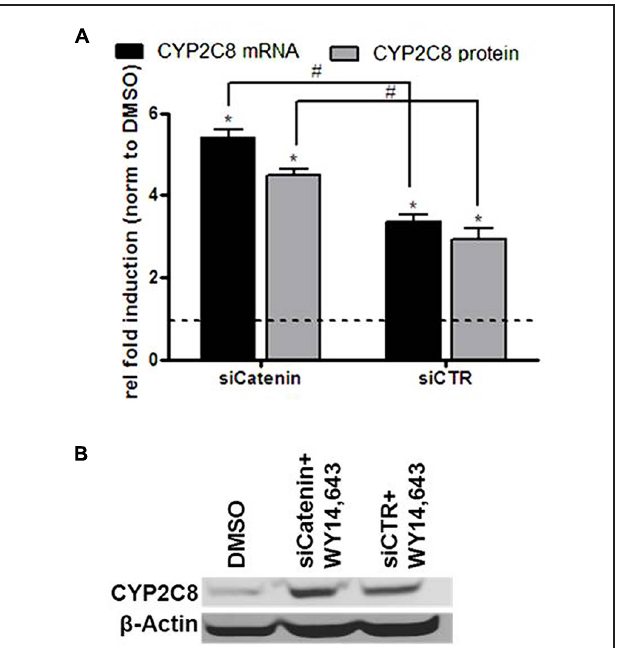
FIGURE 5 | Direct PPAR α -mediated regulation of CYP2C8. (A) Electrophoretic mobility shift assays using in vitro translated proteins was used for assessment the binding of fluorescence-labeled double-stranded oligonucleotide probes corresponding to the indicated regions within CYP2C8 promoter (selection out of 15 tested probes is shown). As a positive control for binding, the known PPAR α /RXR α binding site of the rat ACOX1 gene was used (Thomas et al., 2013). Complexes of PPAR α /RXR α heterodimers with the oligonucleotides are marked by an arrow. (B) Luciferase reporter gene constructs containing the sequences of the CYP2C8 promoter, PBR-A (–9500/–8500 bp) and PBR-C (–2500 to –3500 bp) were cotransfected with a PPAR α expression plasmid and renilla-luciferase expression vector into HuH7 cells. Cells were treated with either 100 μ M WY14,643 or vehicle DMSO for 48 h before measurement of firefly/renilla luciferase activities. Firefly luciferase activities were normalized to renilla luciferase activities to consider changes in the transfection variability and to DMSO control, set as 1. Data are means of three independent experiments, each performed in triplicates in 96-well format; (mut), mutated sites; ∗ , statistically significant ( P < 0.05) compared with DMSO treatment set to 1.